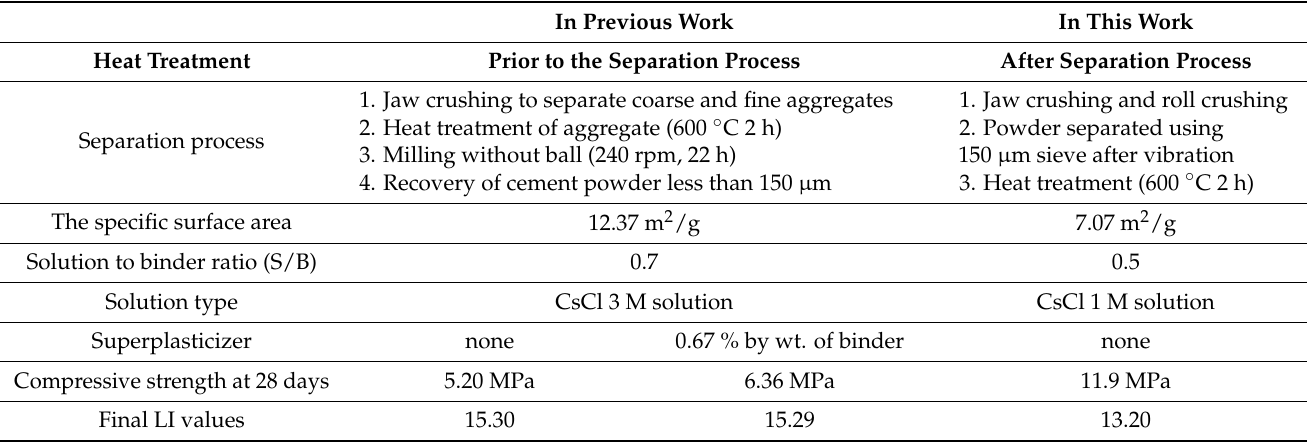
Table 7. A comparison of the properties of recycled cement powder used in previous work and this work. In Previous Work In This